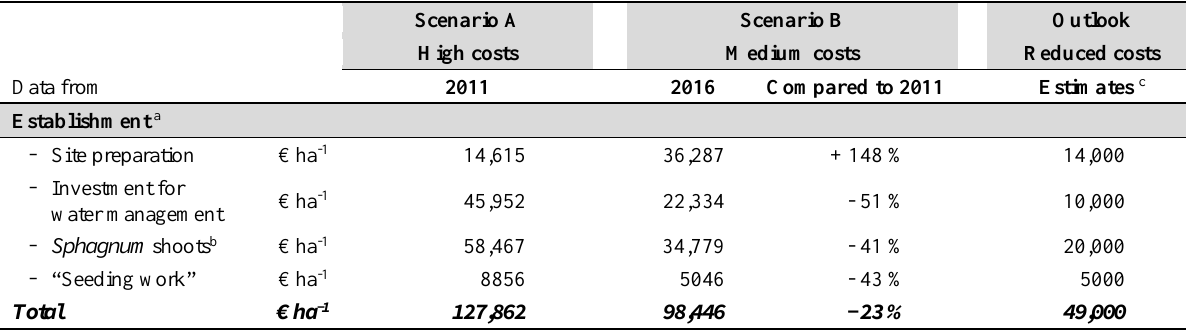
Table A1. Costs of establishing a Sphagnum farming pilot site on former bog grassland, given as proportionate cost per partial net production area (€ ha -1 ).